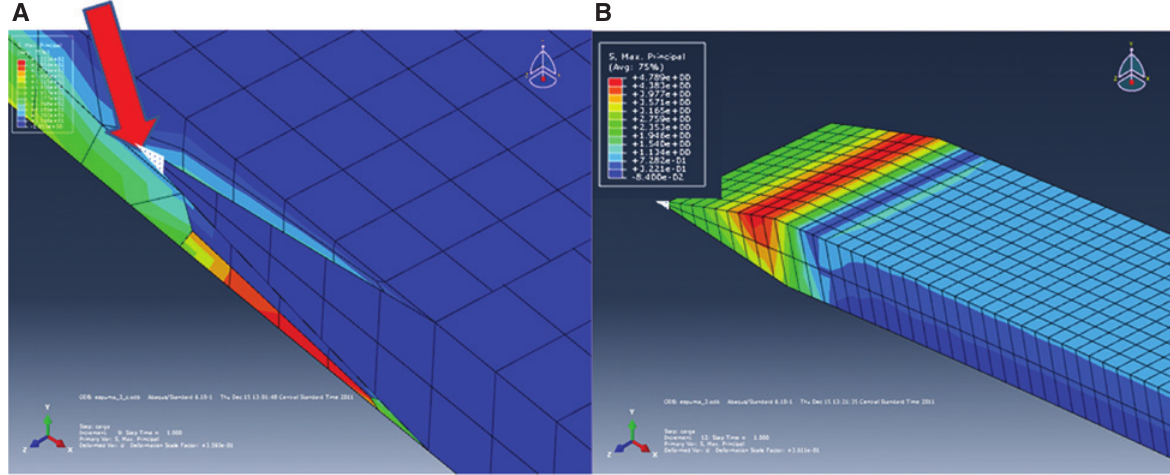
Figure 6 FEA of beam and foam with a manufacturing defect. The foam defect has a minor element